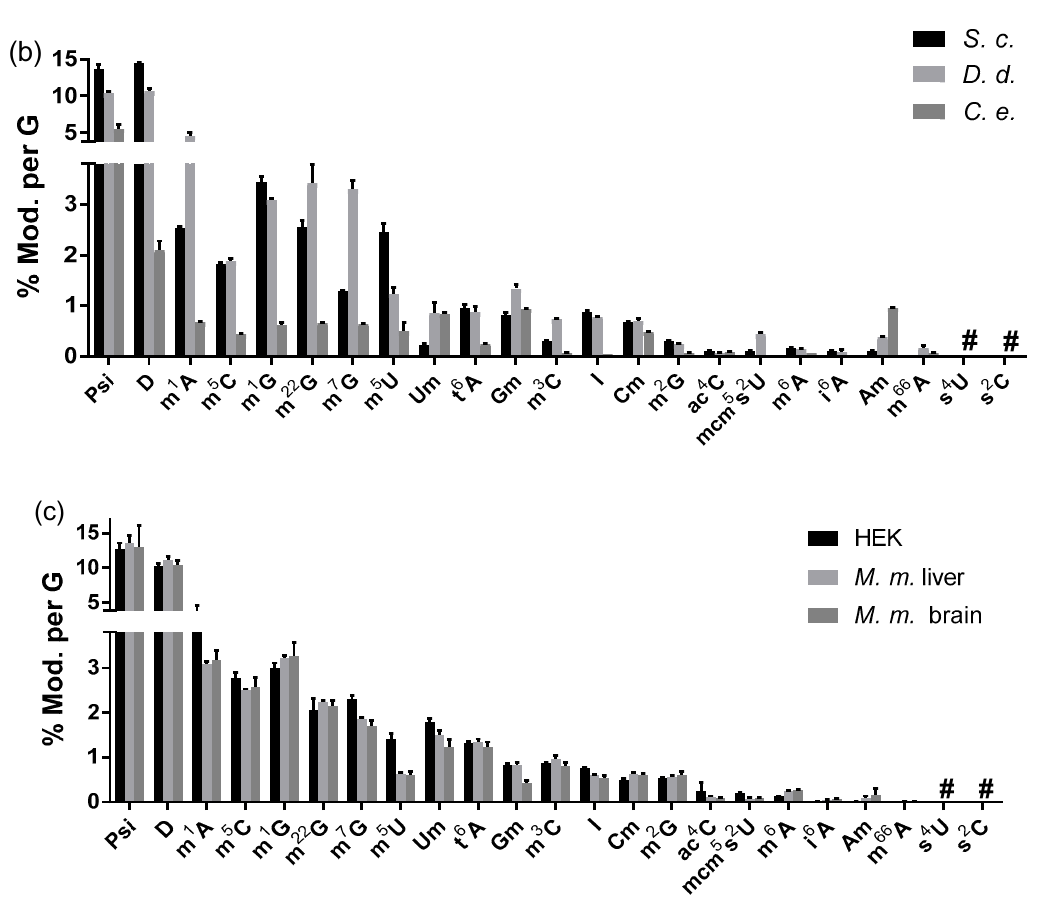
Figure 5. Modification profiles of tRNA from various organisms. ( a ) Comparison of E. coli ( E. c. ) tRNA grown in lysogeny broth (LB) or M9 medium and P. aeruginosa ( P. a. ) tRNA grown in M9 medium. §: for these modified nucleosides, the yeast SILIS was used. For the other bacterial modifications, the E. c. SILIS. ( b ) tRNA modifications in S. cerevisiae ( S. c. ), Dictyostelium discoideum ( D. d. ) and Caenorhabditis elegans ( C. e. ) ( c ) tRNA modifications in tRNA from HEK 293T cells, mouse liver ( M. m. liver) and mouse brain ( M. m. brain). #: These modified nucleosides are absent in the used yeast SILIS and thus s 4 U and s 2 C could not be quantified in these samples. + These modifications are below the LLOQ. The average of n = 3 biol. replicates are plotted. The exceptions are: HEK, P. a., and S. c. each having one biol. replicate and three technical replicates. The error bars reflect the standard deviation.